Question: Write a caption explaining this figure to a reader.
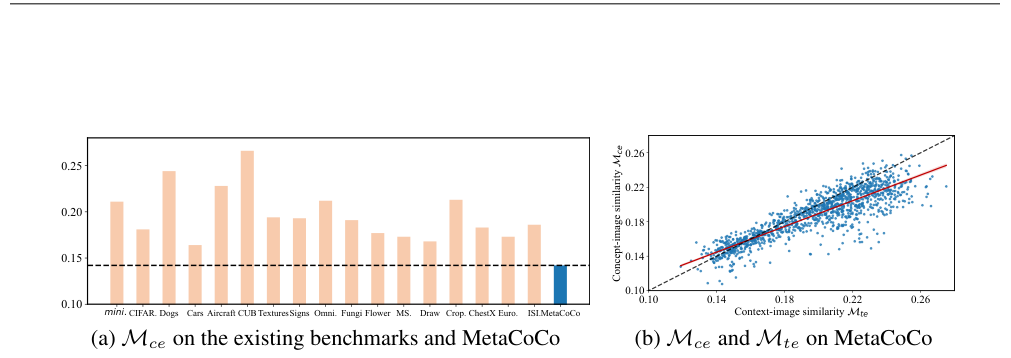
Answer: (a) The sample-averaged similarity Mce between concepts and images on the existing FSC benchmarks and the proposed MetaCoCo, where MetaCoCo has significantly lower similarity between contexts and images. (b) The context-image similarities Mte (horizontal axis) versus the concept-image similarities Mce (vertical axis) of the sample points in the MetaCoCo.